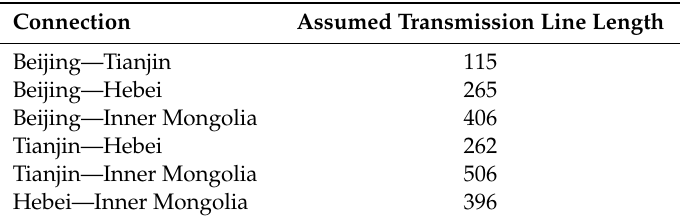
Table 7. Assumed distances between the four model regions (unit: km).